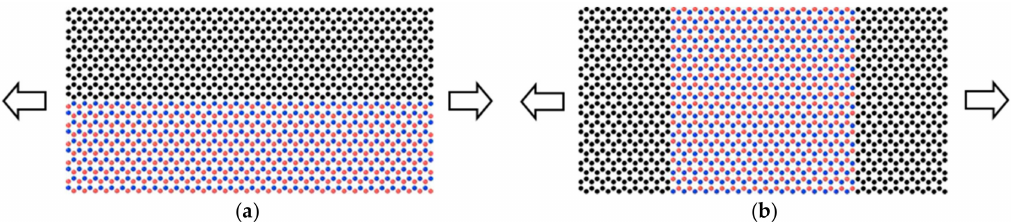
Figure 1. Types of hybrid Boron Nitride-Carbon nanosheets considered in the study. The graphene and BN segments can be arranged in ( a ) parallel or in ( b ) series with respect to the axial direction. The atoms depicted in the ochre color represent boron, those in the blue color represent nitrogen, and those in the black color represent carbon.